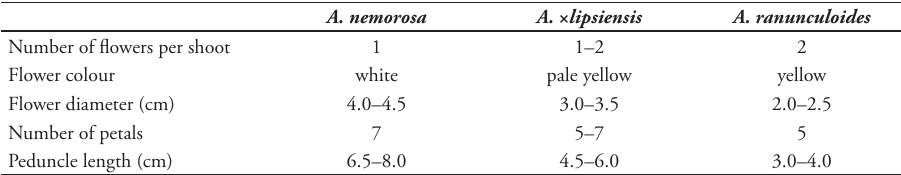
Table 1. Floral morphological features of Anemonoides nemorosa , A. × lipsiensis , and A. ranunculoides in the investigated